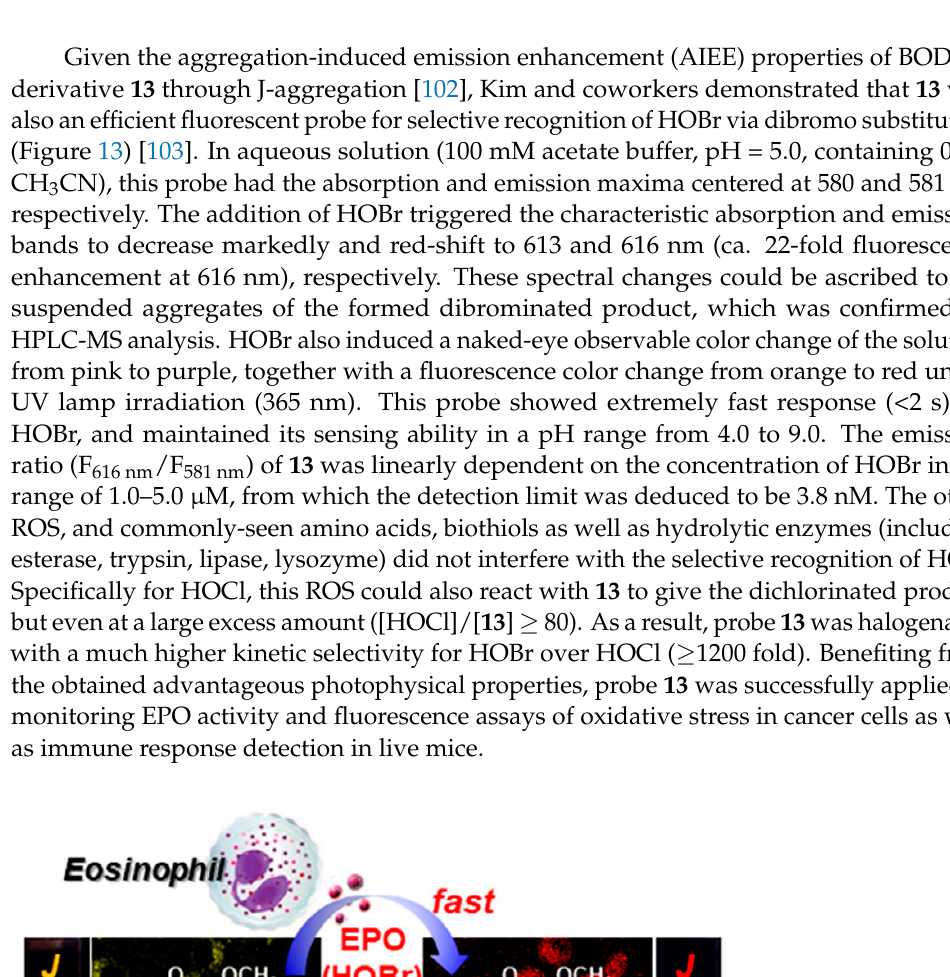
Figure 12. The competitive reaction of HOBr between 12 and biothiols.